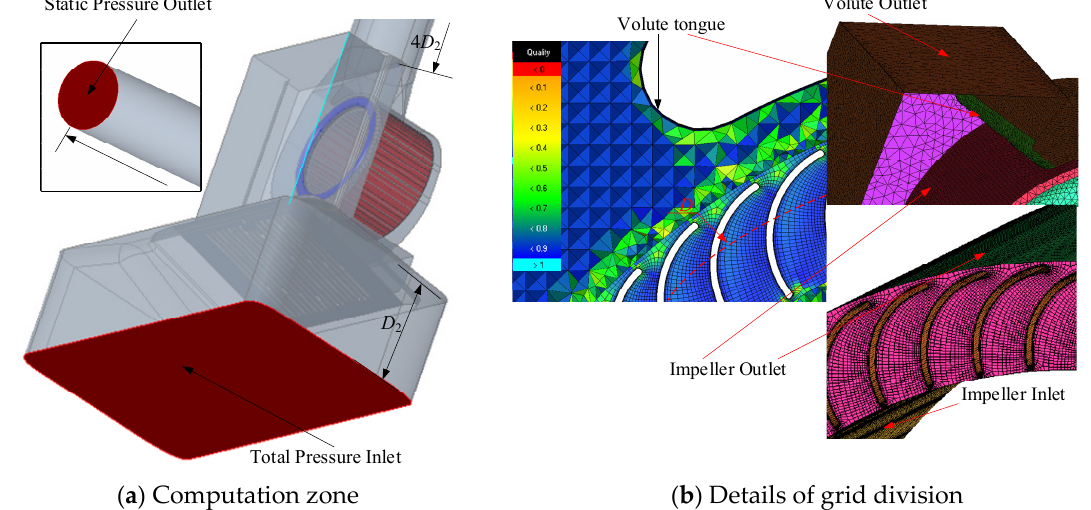
Figure 6. Computation zone and details of grid division.